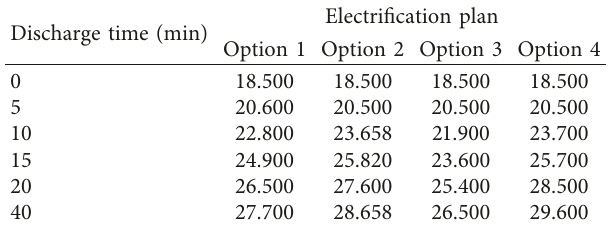
Table 4: Comparison of discharge time data.